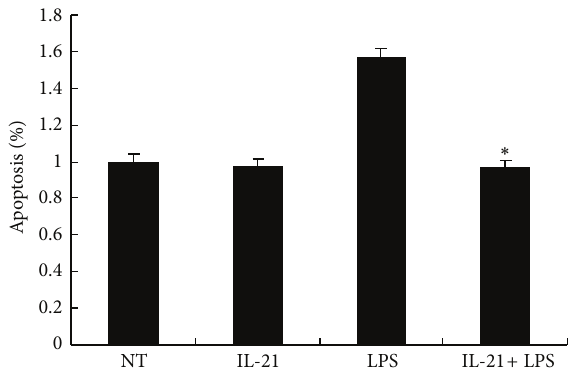
Figure 6: Effects of IL-21 on LPS-induced apoptosis in mouse peritoneal macrophages. Macrophages ( 1×10 6 ) were incubated with IL-21 (100ng/mL) in the presence or absence of LPS (100ng/mL) for 24h and were stained with FITC-conjugated Annexin V and propidium iodide (PI). Values are presented as mean ± SD of three independent experiments. ∗ 𝑃 < 0.05 compared with the LPS